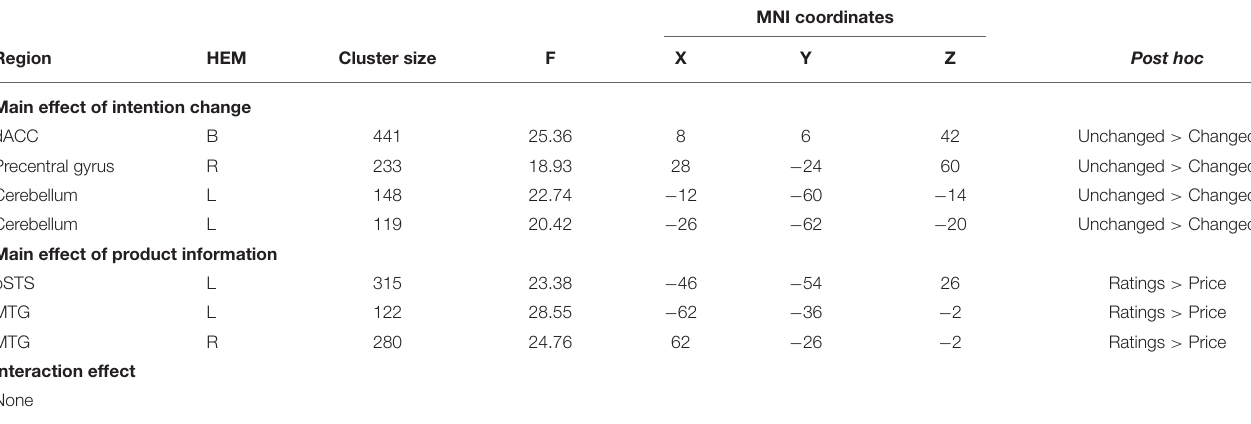
MNI coordinates